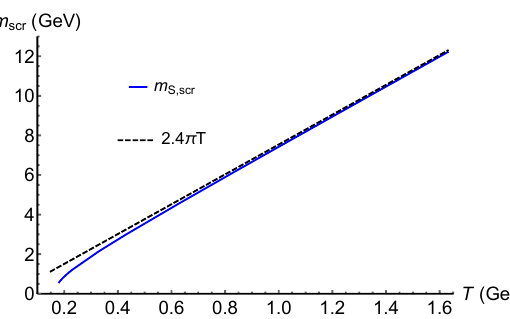
Figure 10 . The temperature dependence of the screening mass of the scalar meson in the high temperature limit with m q = 0